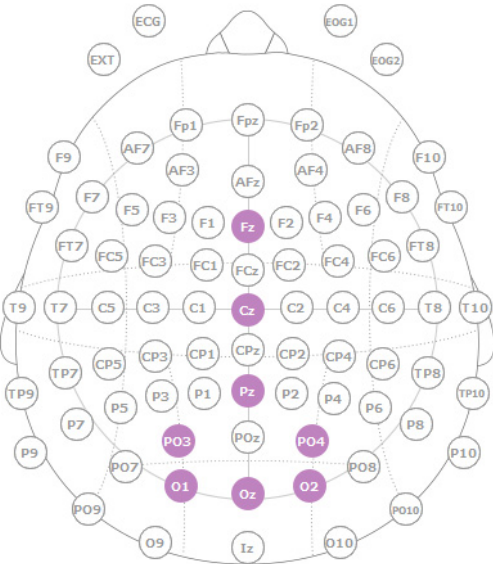
Figure 6. Electrode disposition according to the international system 10–20.